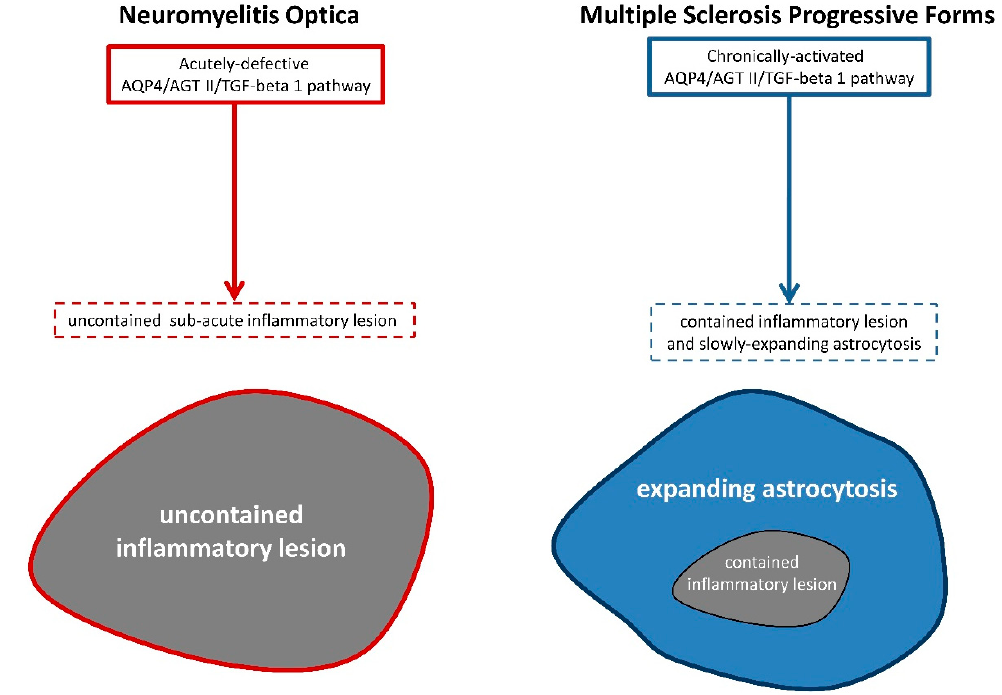
Figure 1. Due to the presence of autoantibodies directed against Aquaporin 4 (AQP4), the molecular pathway putatively linking AQP4, angiotensin II (AGT II) and the anti-inflammatory/progliotic molecule transforming growth factor beta 1 (TGF-beta 1) is ineffective in patients suffering from neuromyelitis optica. As a consequence, large uncontained inflammatory lesions develop in a sub-acute fashion. On the contrary, due to the overexpression of AQP4 on astrocytes localized in periplaque areas, plaque-associated inflammation remains contained by TGF-beta 1, however astrocytosis extends distance away from plaque borders.